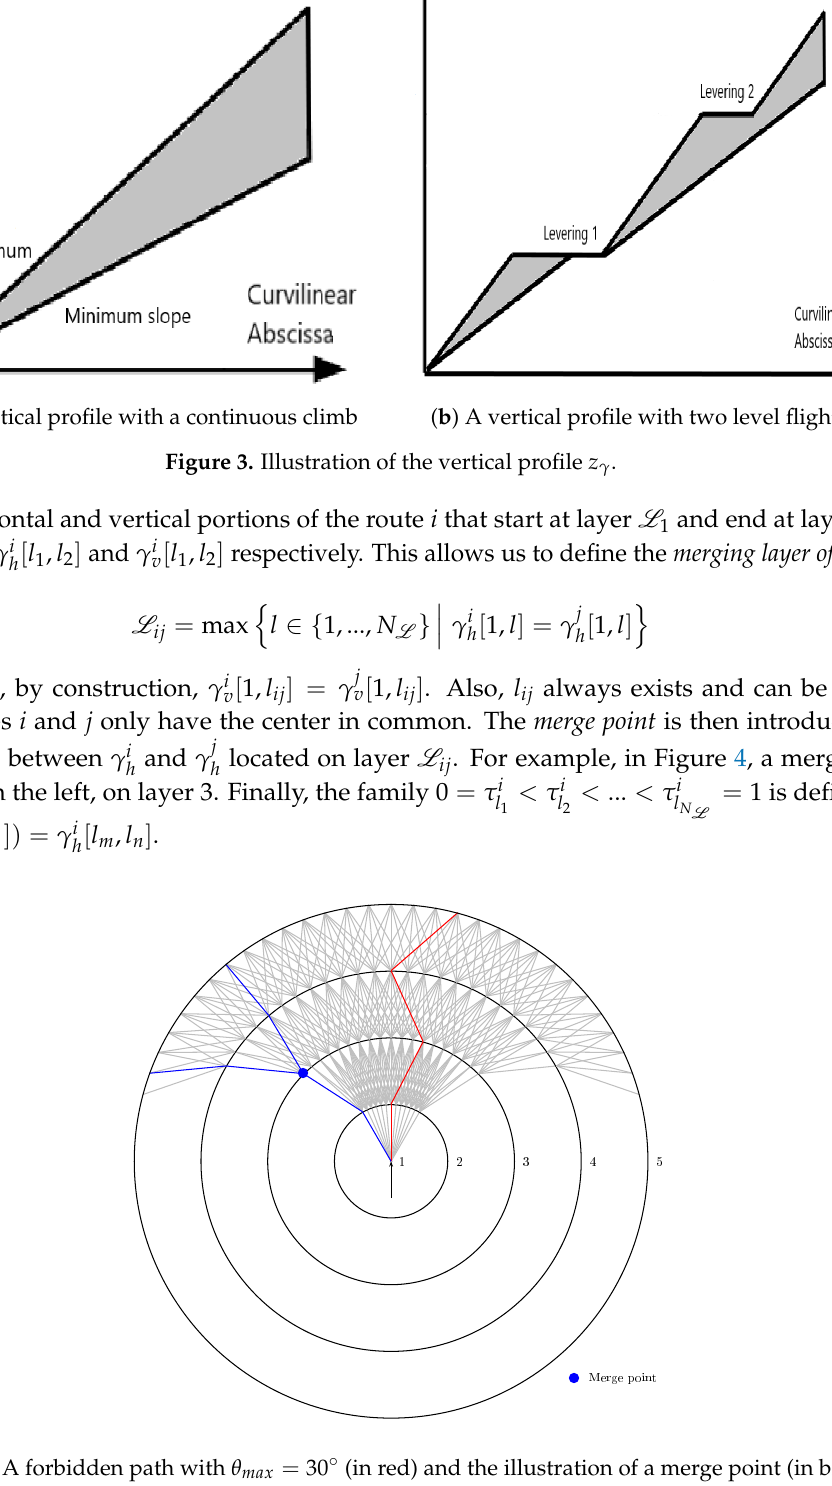
Figure 4. A forbidden path with θ max = 30 ◦ (in red) and the illustration of a merge point (in